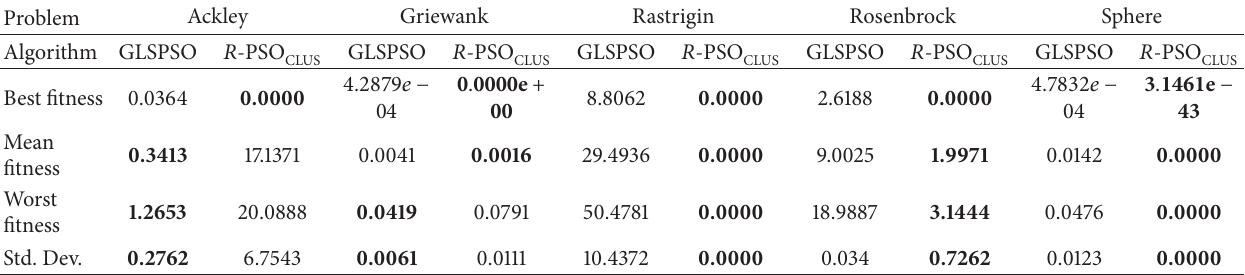
for problems with dimension of 10. CLUS